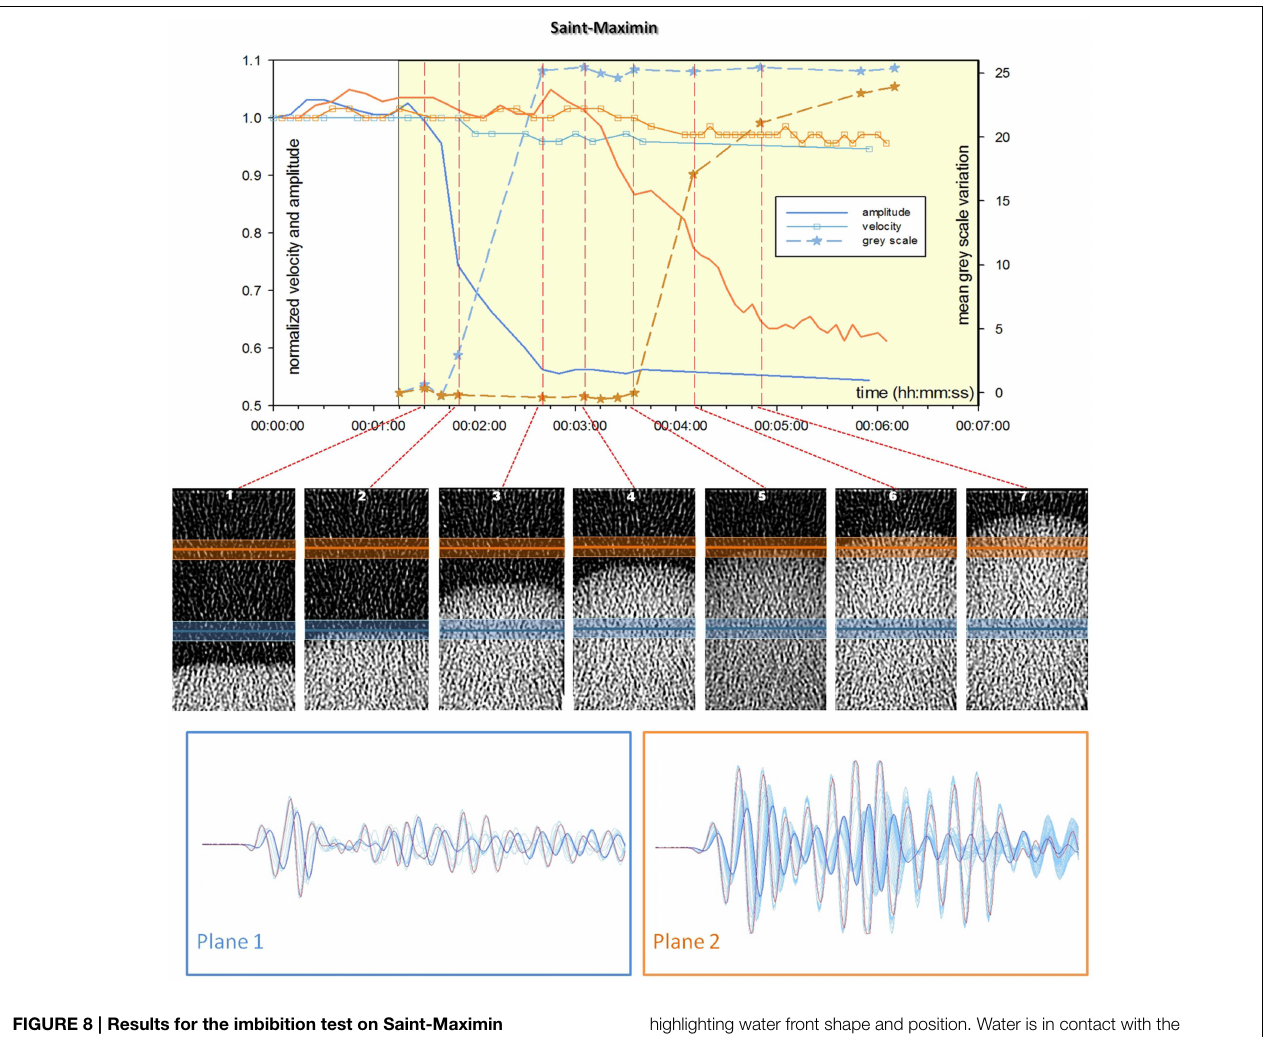
FIGURE 8 | Results for the imbibition test on Saint-Maximin grainstone: evolution as a function of time of normalized velocity and first peak amplitude recorded on planes 1 and 2 and mean gray level value calculated along these planes on selected CT volume. Processed X-ray cross section located in the middle of the sample